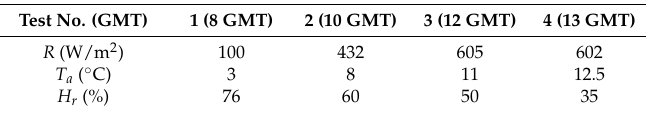
Table 1. Weather conditions for punctual measurements on 2 February 2010. GMT: Greenwich Mean Time.